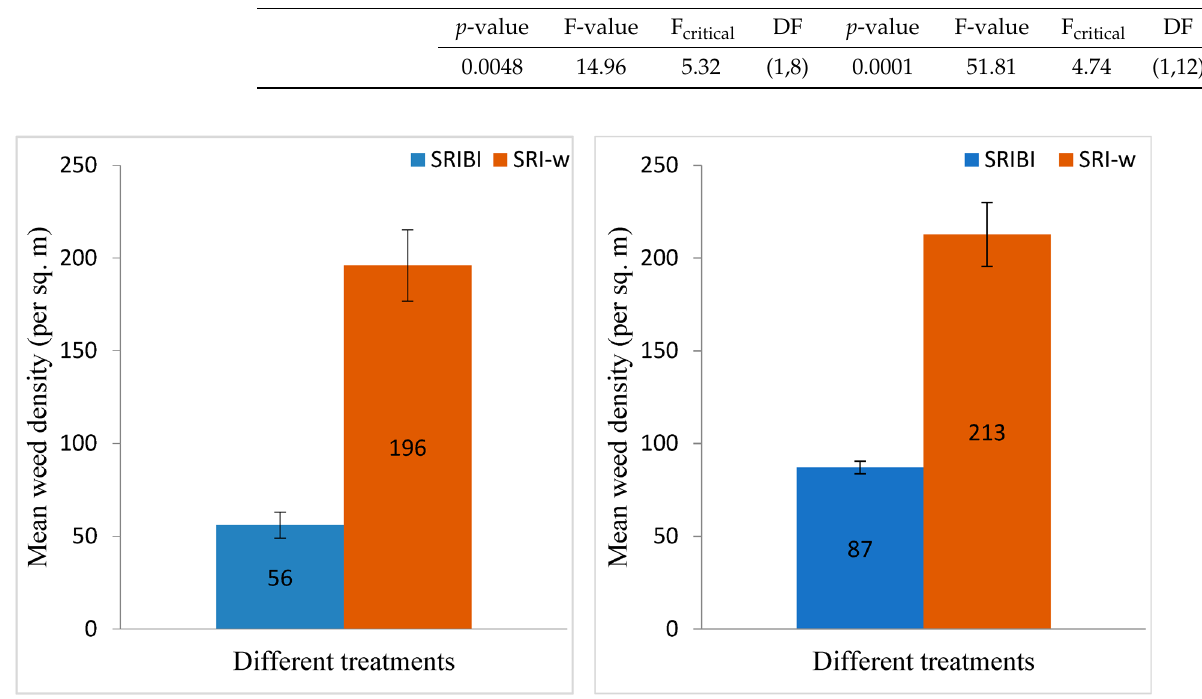
128 Table 4. A comparison of plant height parameters observed for the three different treatments (2020).